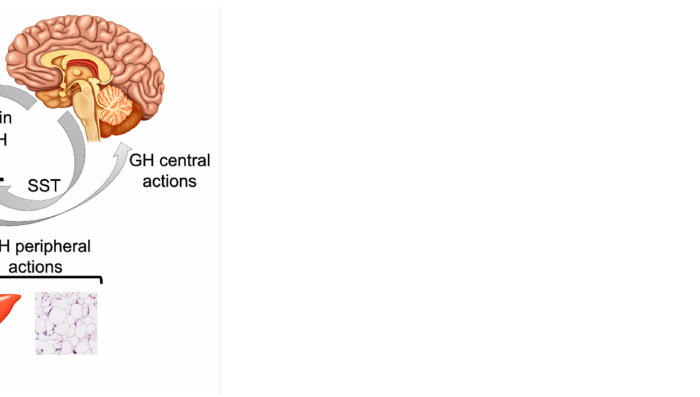
Figure 1. Neuroendocrine factors that control the pulsatile secretion of growth hormone (GH). Ghrelin and GH-releasing hormone (GHRH) stimulate pituitary GH secretion, whereas somatostatin (SST) inhibits it. The example of the pulsatile secretion of GH was obtained from a C57BL/6 eight- week-old male mouse after 36 serial blood collections in a 10-min interval (lights on at 7 am; 12-h light/dark cycle). Note that GH has central and peripheral actions (e.g., on the liver, muscle and white adipose tissue), in which the stimulation of insulin-like growth factor 1 (IGF-1) secretion from the liver plays a major role controlling somatic